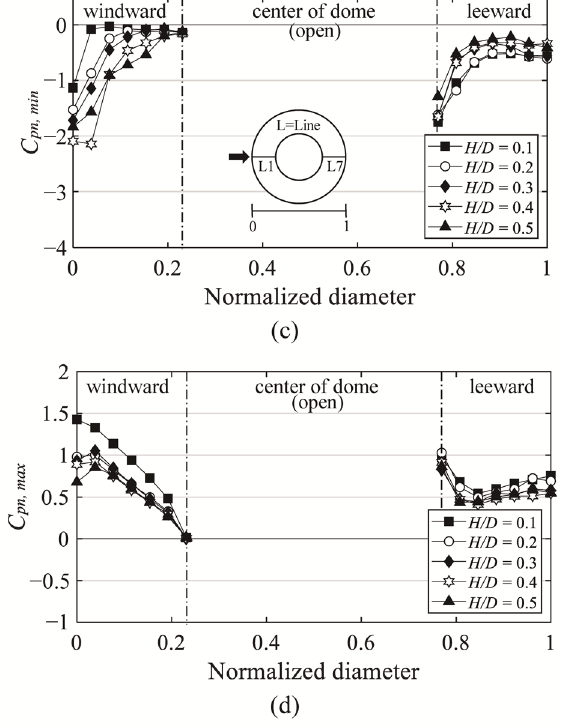
Figure 19. Variation of C pn,mean , C pn,min , and C pn,max depending on H/D and pressure time histories: ( a ) C pn,mean ; ( b ) time histories of external, internal, and net pressures; ( c ) C pn,min ; and ( d ) C pn,max .